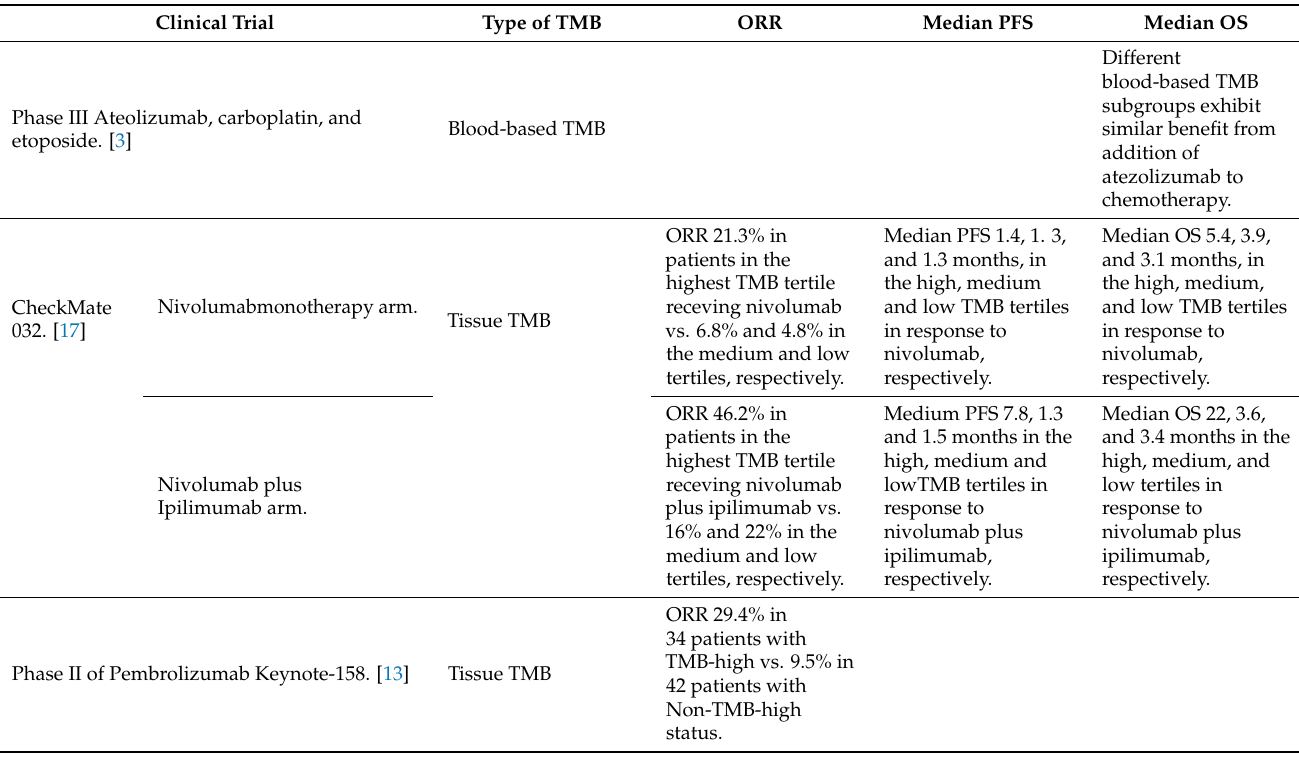
Table 2. Studies concerning TMB in